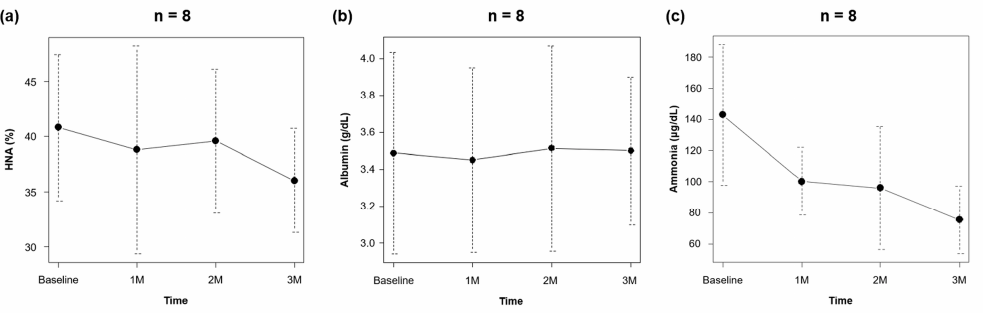
Figure 1. Change in ( a ) HNA and serum ( b ) albumin and ( c ) ammonia levels during rifaximin therapy. Abbreviation: HNA, human nonmercaptalbumin. Table 1. Changes in each variable during rifaximin therapy.